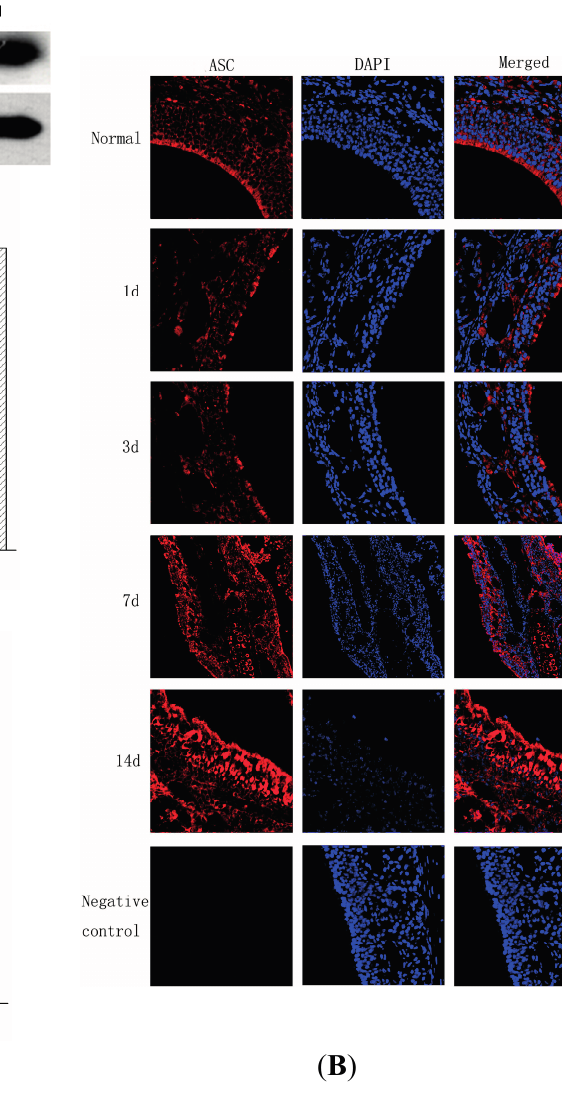
Figure 4. The expression of total ASC protein and ASC mRNA in the right nasal mucosa of mice. ( A ) Western blot assessment of the protein expression of ASC in the control group (group A), and 1, 3, 7, and 14 days (groups B, C, D, and E, respectively) after stimulation with S. aureus . A semi-quantitative analysis was used to represent the total protein level of ASC; ( B ) Immunofluorescence showed that ASC was mainly expressed in the cytoplasm of cells in the nasal mucosa; and ( C ) Real-time PCR assessment of the mRNA expression of ASC in the control group (group A), and 1, 3, 7, and 14 days (groups B, C, D, and E, respectively) after stimulation with S. aureus (* indicates p < 0.05; ns = not statistically